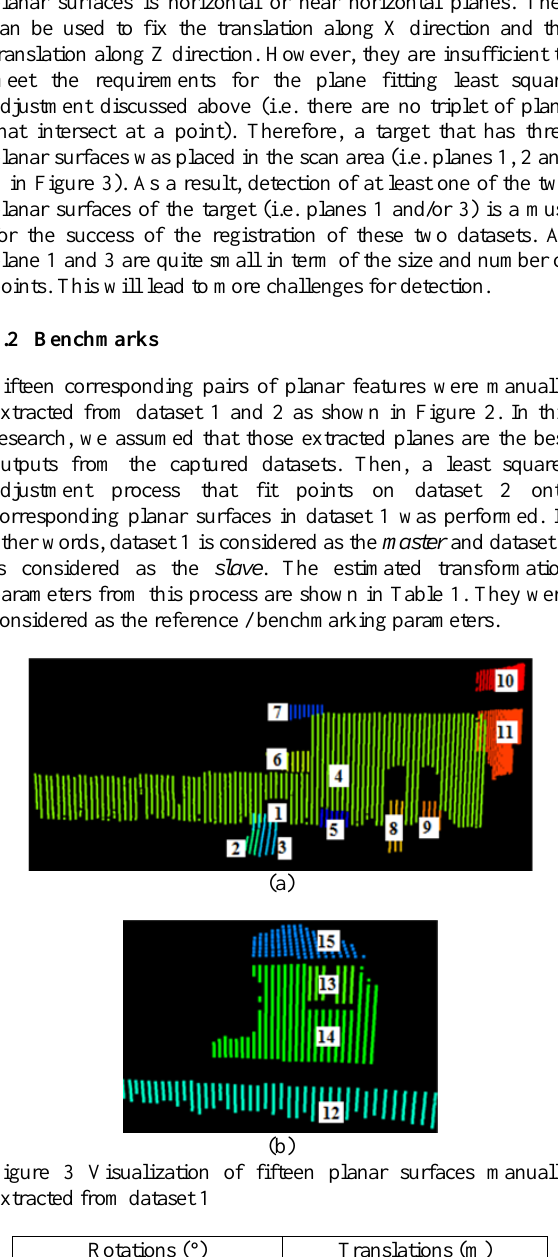
Table 4 RMSs of the points fitted onto their models before